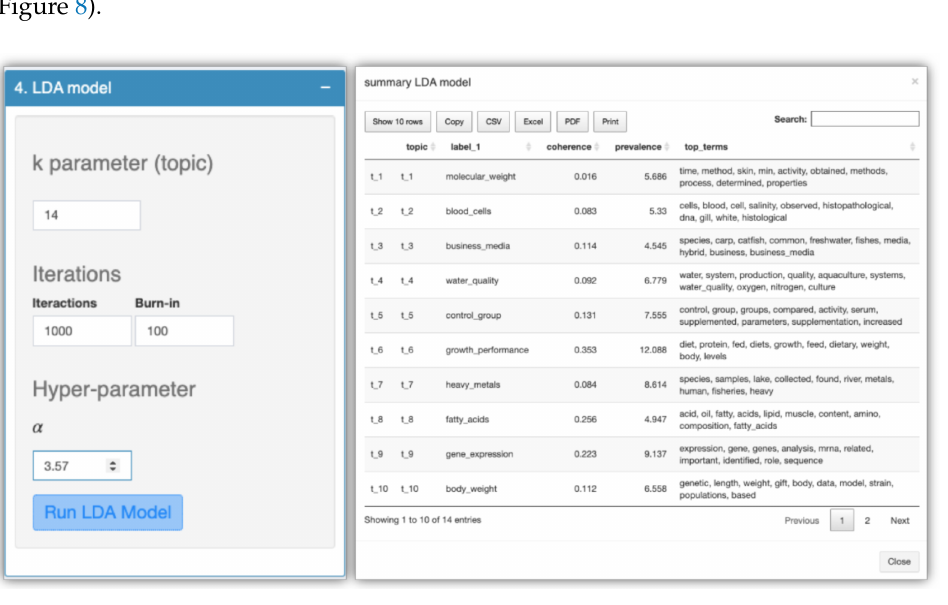
Figure 8. Configuration options used to calculate LDA